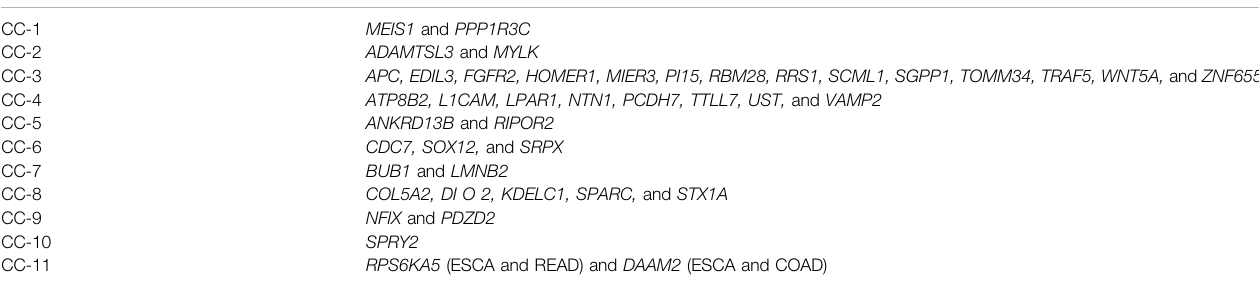
TABLE 2 | Commonly shared mRNAs between ceRNA networks of GI cancers.